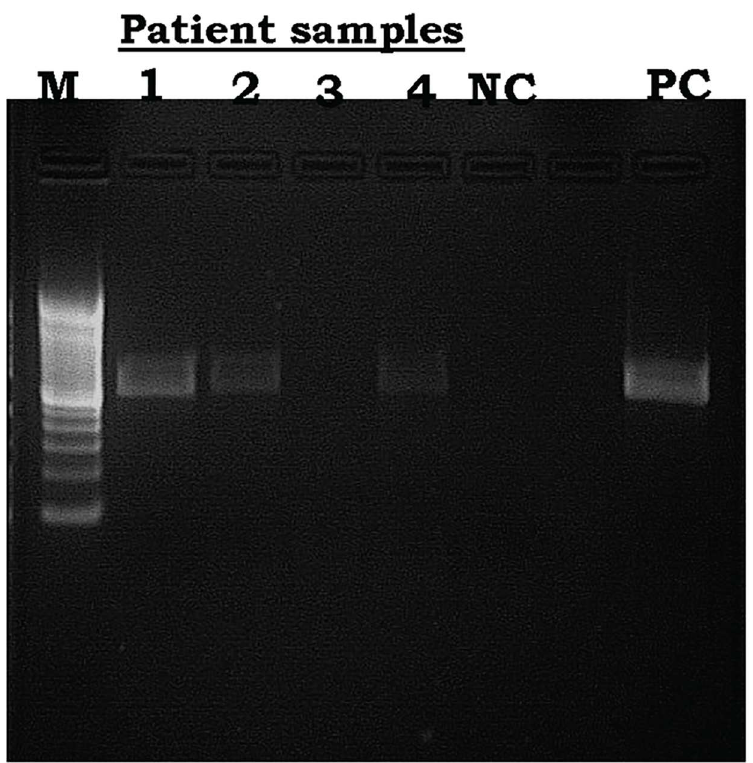
Fig 5. Leishmania major detection from four of the 11 tissue aspiratesobtained from lesions of active CL cases. M = ladder100bp,lanes 1–4 = samples, NC = negativecontrol, PC = Positive Control ( L . major